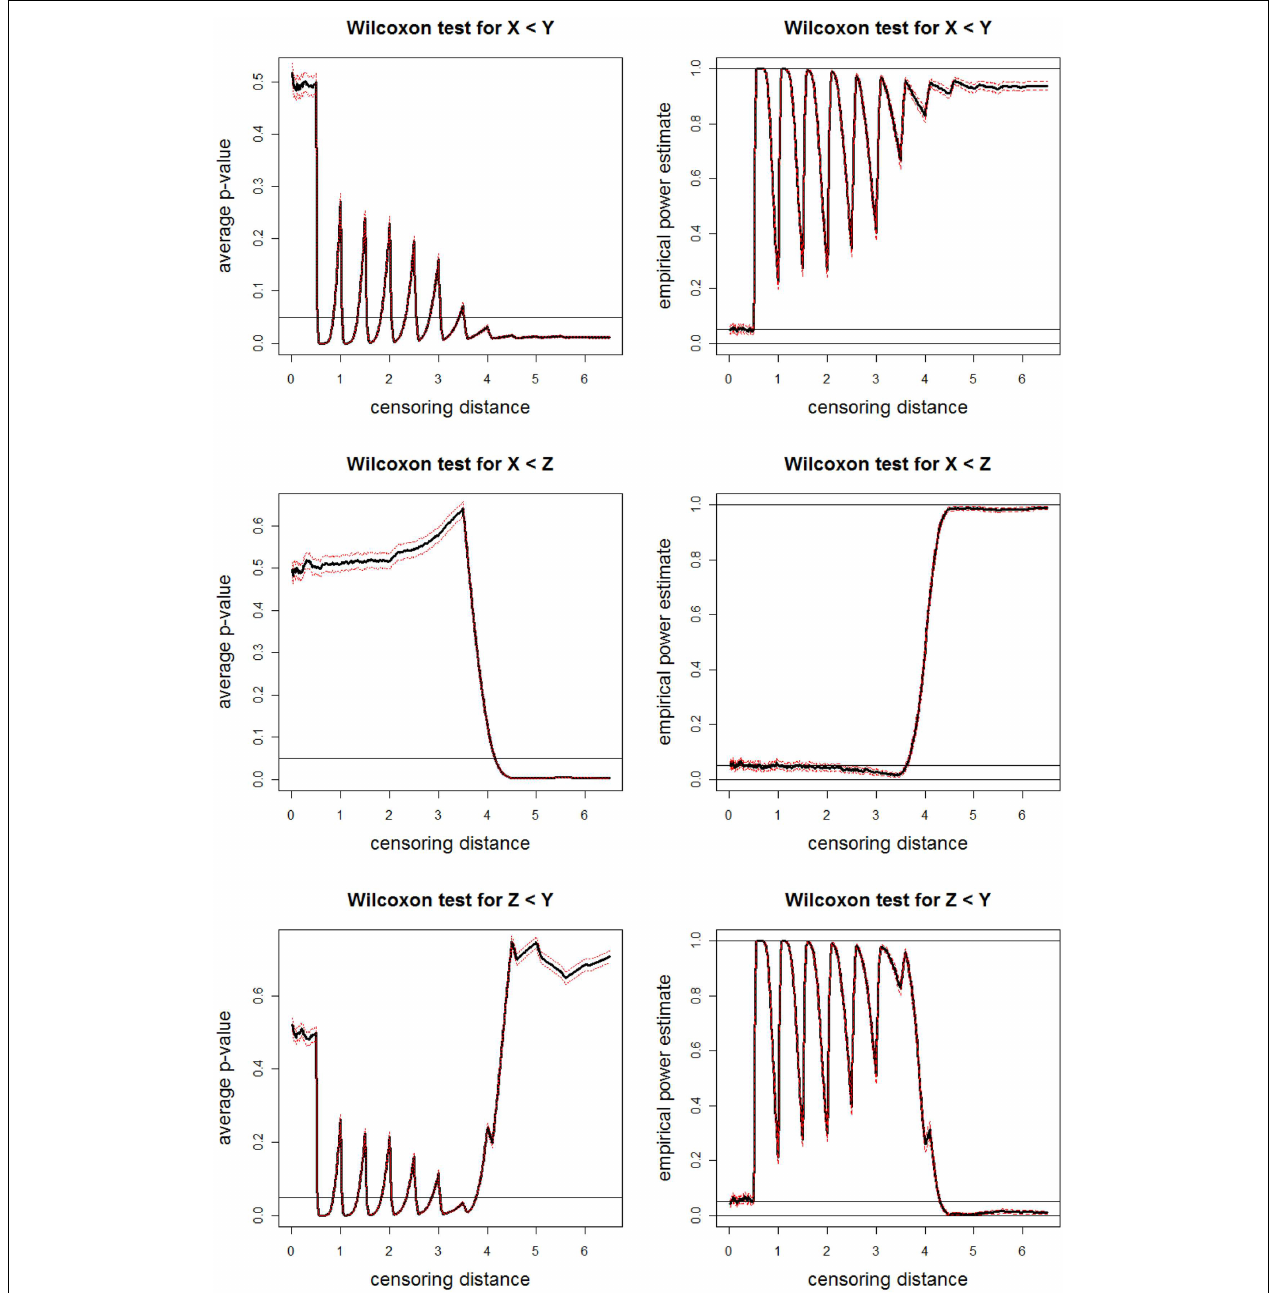
FIGURE 11 | Plotted in the left are the average p -values (solid lines) and in the right are empirical power estimates (solid lines) versus censoring distance values forWilcoxon rank sum test for the left-sided alternatives